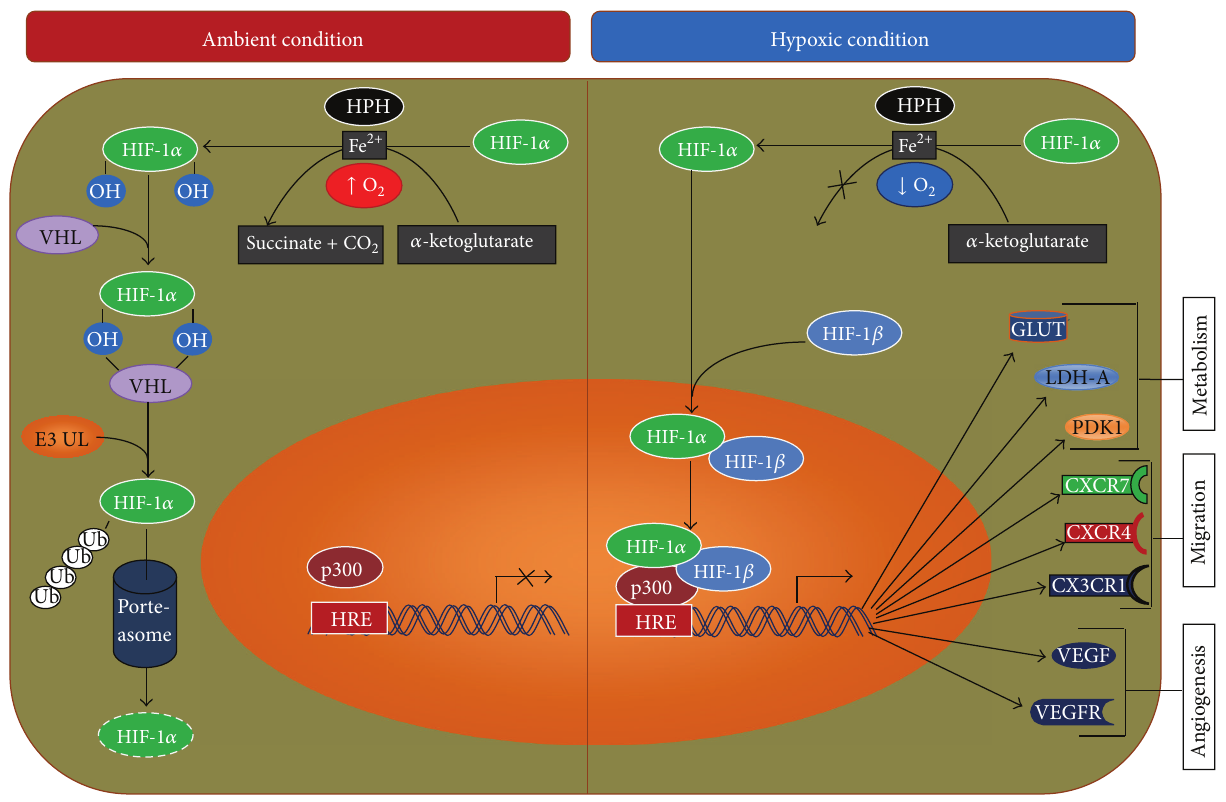
Figure 2: Regulation of transcription by HIF-1 during ambient and hypoxic condition. HIF: hypoxia-inducible factor; HPH: HIF-1 prolyl- hydroxylases;VHL:VonHippel-Lindau;E3UL:E3ubiquitinligase;HRE;hypoxia-responseelement;GLUT;glucosetransporter:LDH:lactate dehydrogenase; PDK, pyruvate dehydrogenase kinase (see text for